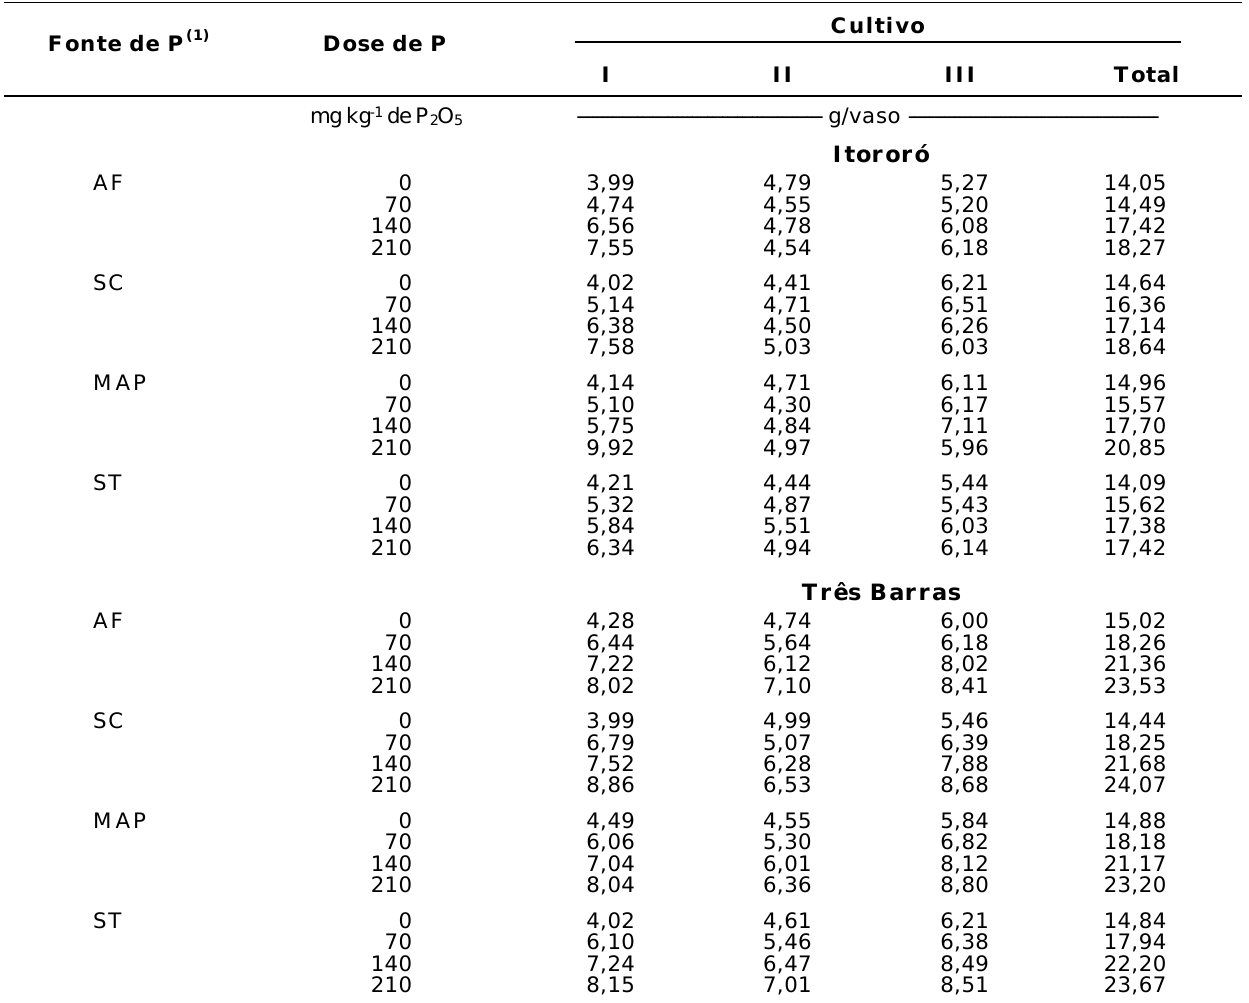
figuras 3 e 4, cuja análise demonstra que o compor- tamento agronômico dos fosfatos avaliados foi semelhante. Esse resultado era previsível, visto que as fontes utilizadas apresentam elevada solubilidade em água, característica que determina, em grande parte, a eficiência agronômica dos fosfatos (Webb et al.,1961; Goedert & Sousa, 1986 e Chien et al., 1990). Outro fator a ser considerado é a forma física de aplicação das fontes de fósforo, pois os fertilizantes líquidos entram em contato com maior volume de solo, em comparação aos sólidos, o que favorece as reações de fixação do fósforo, reduzindo sua disponibilidade para as plantas. Por essa razão, atribui-se a equivalência verificada, entre as fontes fluidas e sólidas, ao fato de MAP e ST terem sido aplicados na forma de pó, possibilitando íntimo contato com os constituintes do solo. É provável, porém, que, com a granulação, essas fontes sólidas apresentem desempenho superior ao das fontes